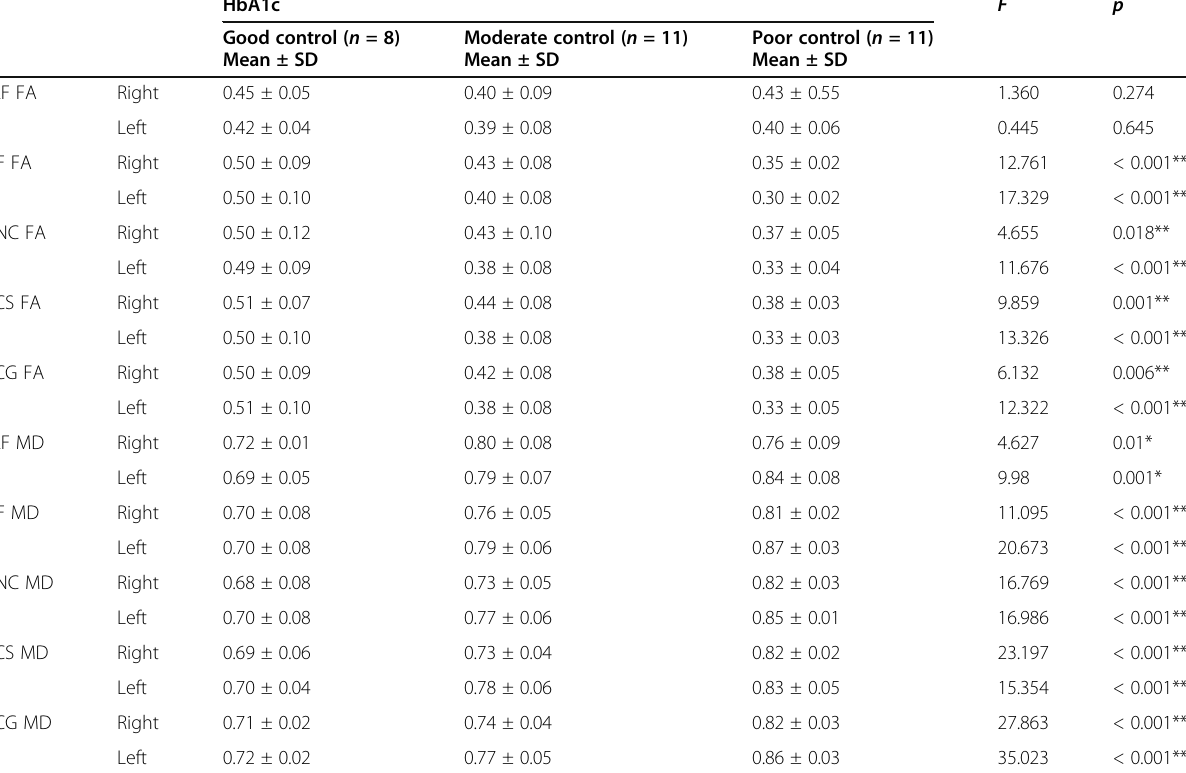
Table 7 Mean values of fractional anisotropy, mean diffusivity in diabetics according to glycemic control ( n = 30) HbA1c